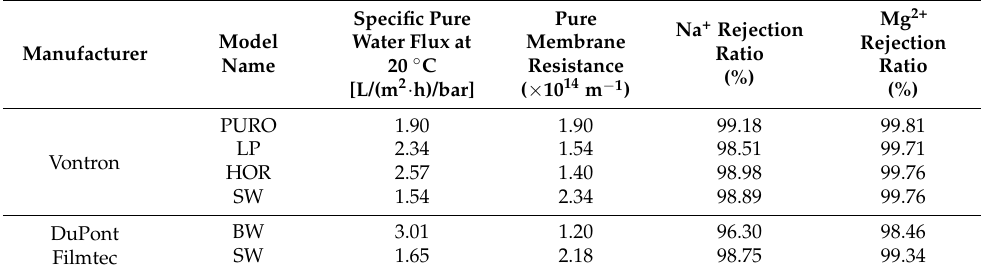
Figure 1. Changes in pure water flux with TMP for new RO membranes. Table 1. Permeability and selectivity of new RO membranes.